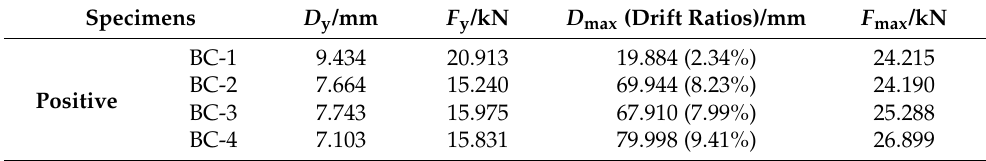
Table 6. Feature points of all joint